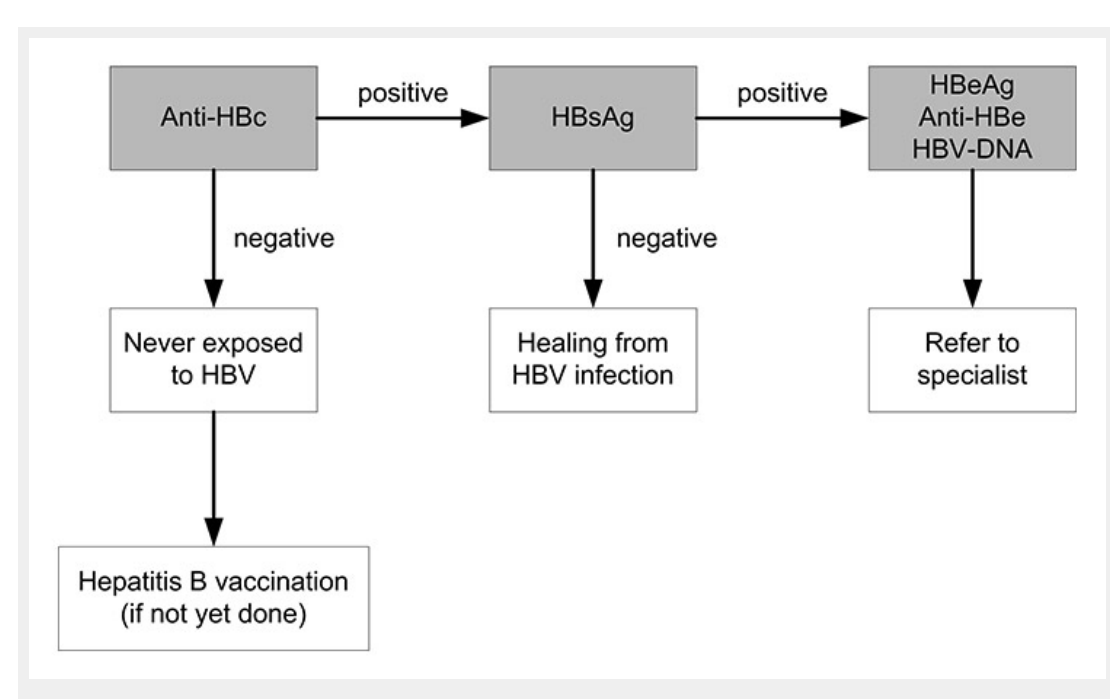
Figure 1 Testing for chronic hepatitis B virus (HBV) infection: absence of anti-HBc excludes HBV infection, while the presence of HBsAg indicates ongoing infection. Anti-HBc = antibody to hepatitis B core antigen; Anti-HBe = antibody to hepatitis B ‘e’ antigen, HBeAg = hepatitis B ‘e’ antigen; HBsAg = hepatitis B surface antigen; HBV DNA = HBV deoxyribonucleic